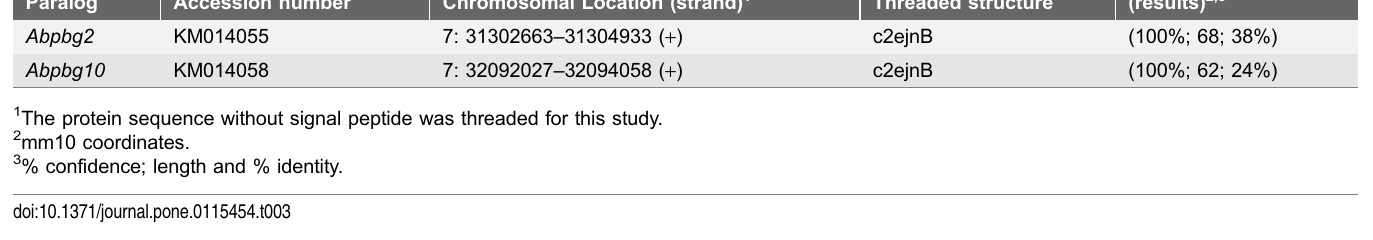
Table 3. Mouse Abpbg2 and Abpbg10 genes 1 used to produce molecular models.